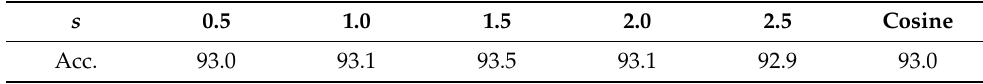
Table 6. Results corresponding to different scale factors